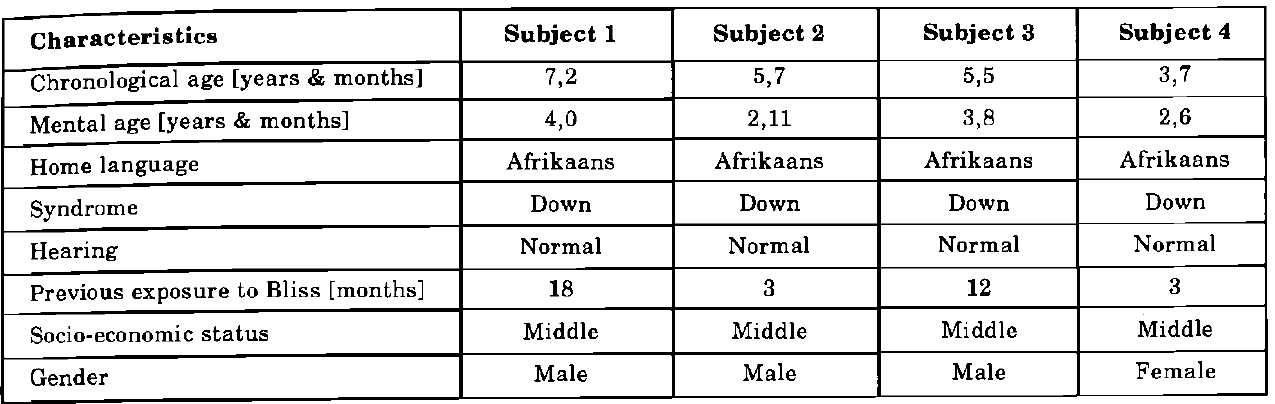
Table 1. Description of subjects (N=4) Characteristics